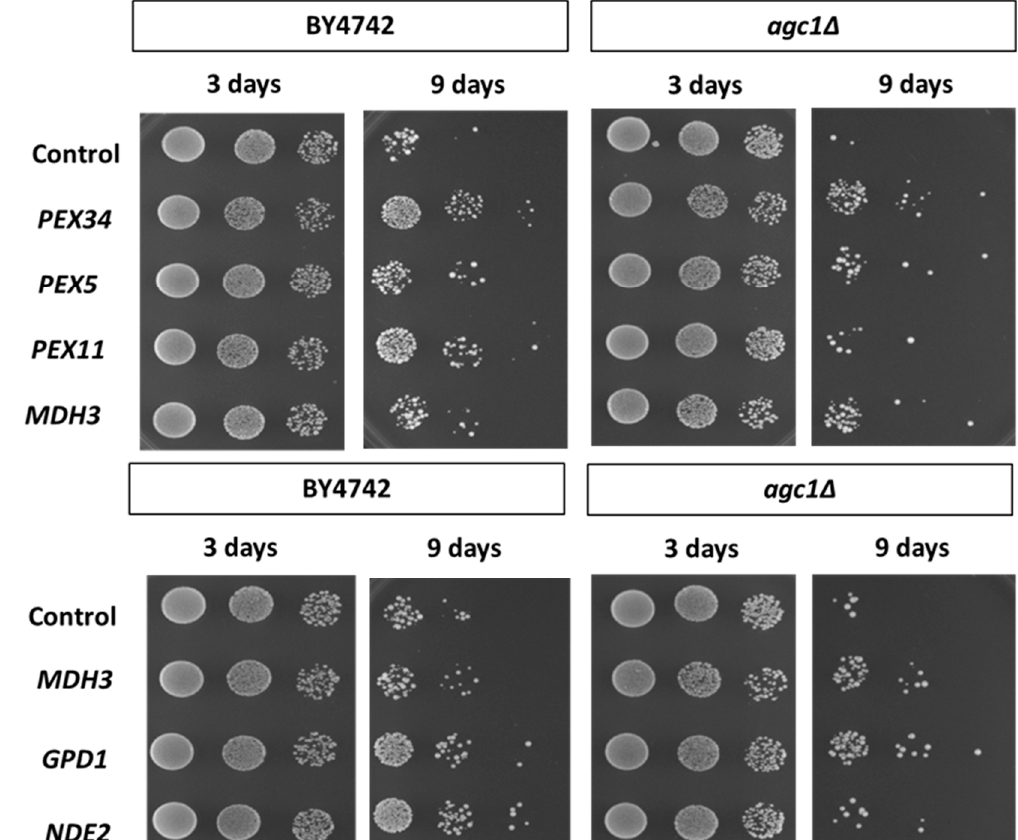
Figure 3. Effects of over-expression of peroxisomal genes and NAD + regeneration genes on the chronological longevity of agc1 Δ yeasts. Wild-type and agc1 Δ yeasts containing expression plasmids of peroxisomal genes and NAD + regeneration genes as indicated were cultured in SD broth supplemented with 2% glucose and tested for chronological longevity. The yeast array on an SD plate supplemented with 2% glucose indicated viability starting with 10 5 , 10 4 , and 10 3 cells. Note that agc1 Δ yeasts had decreased chronological longevity, and GPD1 , MDH3 , and PEX34 over-expression increased the longevity of agc1 Δ yeasts.